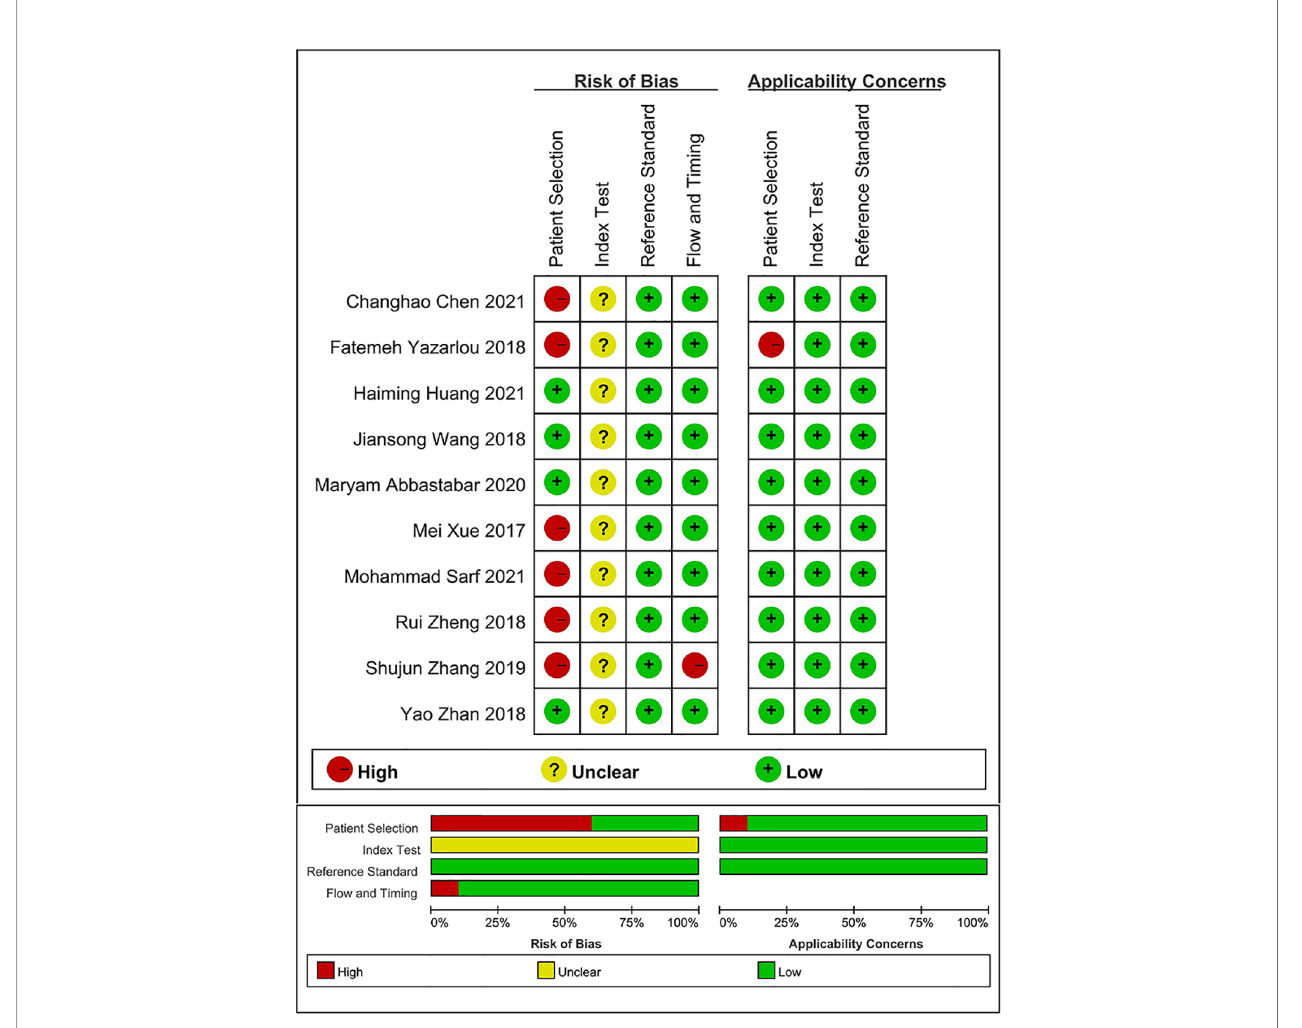
FIGURE 2 | QUADAS-2 entries for evaluation of literature